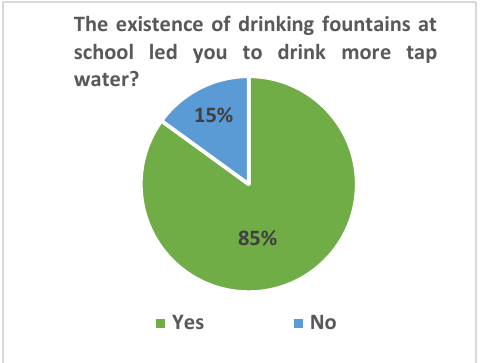
Figure 7. Impact of drinking fountains.